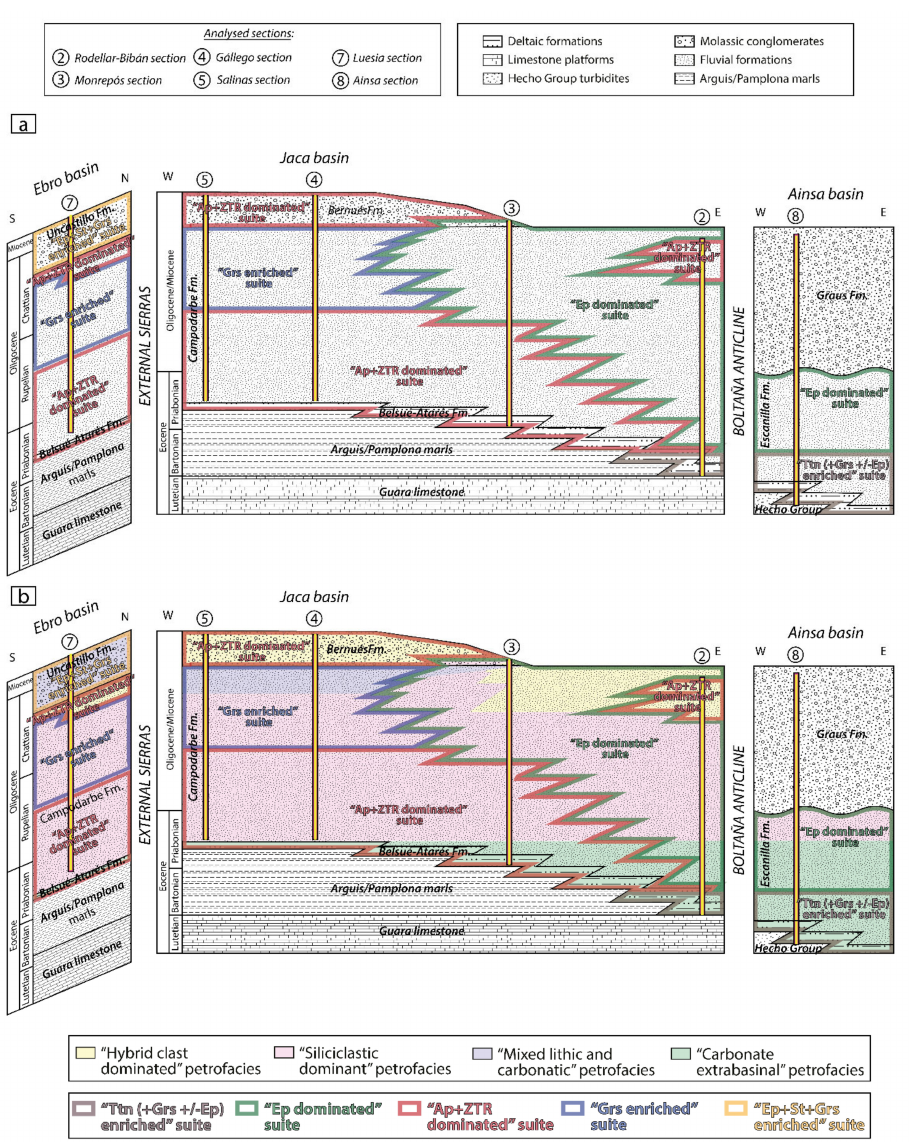
Figure 8. ( a ) Colored stratigraphic cross-section in order to illustrate the distribution of the heavy- mineral suites laterally and through time. ( b ) Colored stratigraphic cross-section in order to illustrate the distribution of the petrofacies and heavy-mineral suites laterally and through